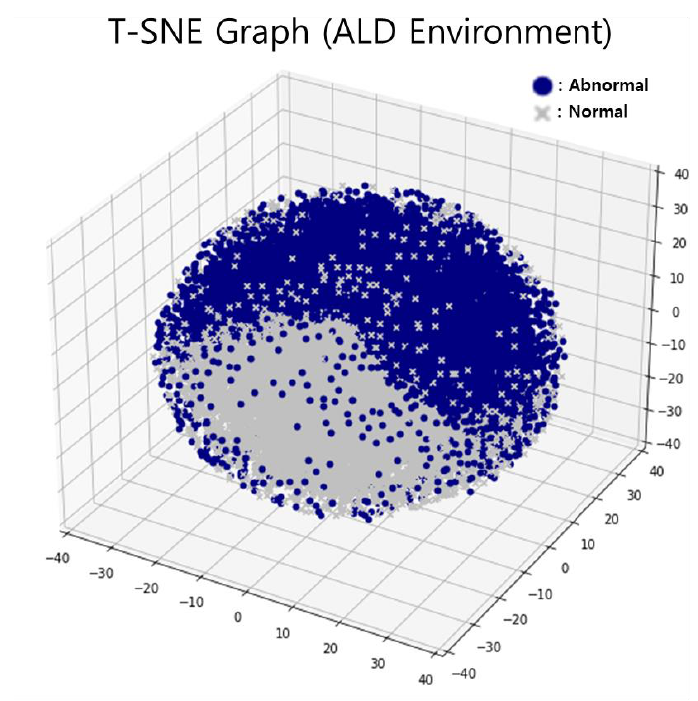
Figure 8. T-SNE graph in ALD environment.